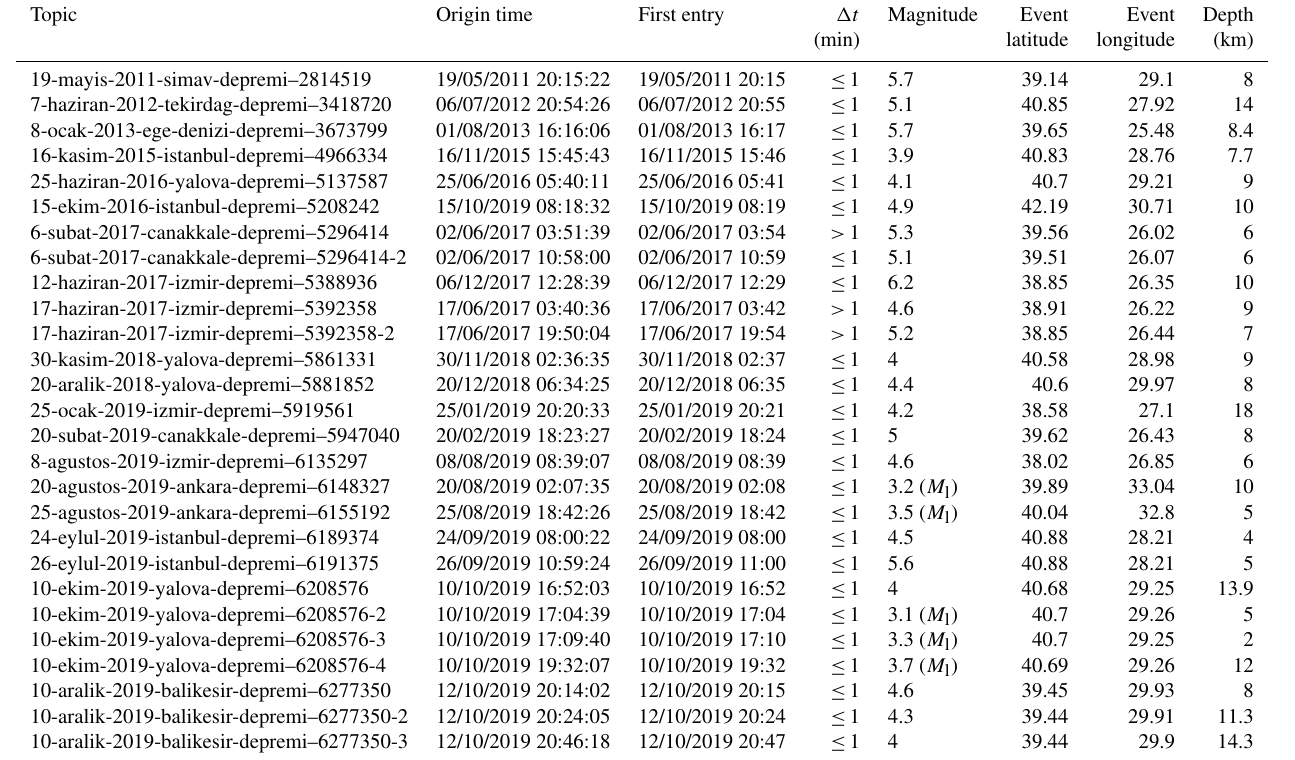
Table 1. Topics of various earthquakes on the Ek¸si Sözlük site. The first entry, additionally, gives the information of the creation time (with the date, given as dd/mm/yyyy, and the time stamp of the entry in universal coordinated time) of the topic. (cid:49)t is the time between the origin time of the earthquake and the creation of the topic of the earthquake. Entries under the first entry do not provide the seconds in the time stamp. Magnitudes are moment magnitude ( M w ), unless otherwise